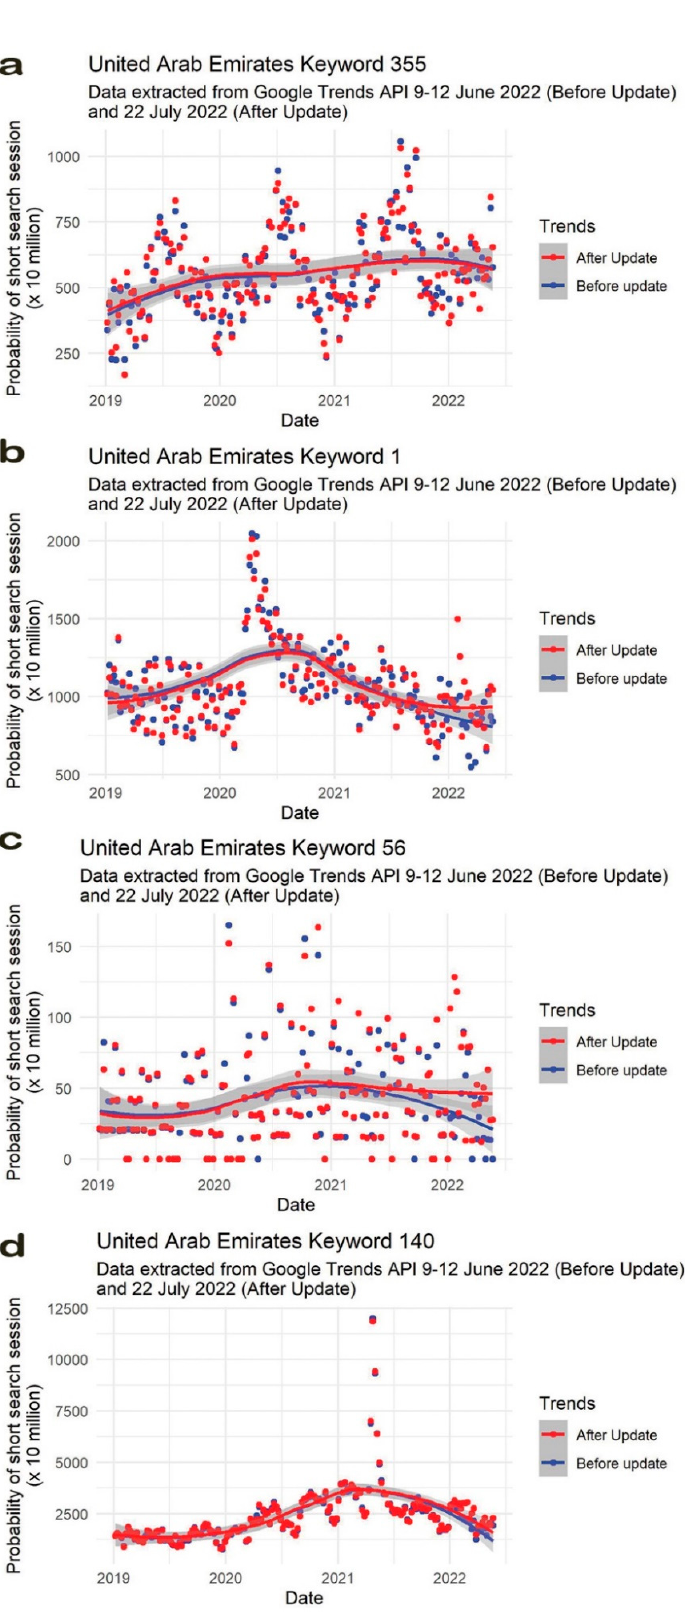
Figure 2. Example plots for four ( a – d ) arbitrarily selected search terms in the United Arab Emirates. LOESS was applied to visually identify potential trends. In most plots, a divergence occurs between the smoothed time series after 2022. The 12,630 figures are publicly available here: https://doi.org/10.25415/ujhb.20424642.v22.